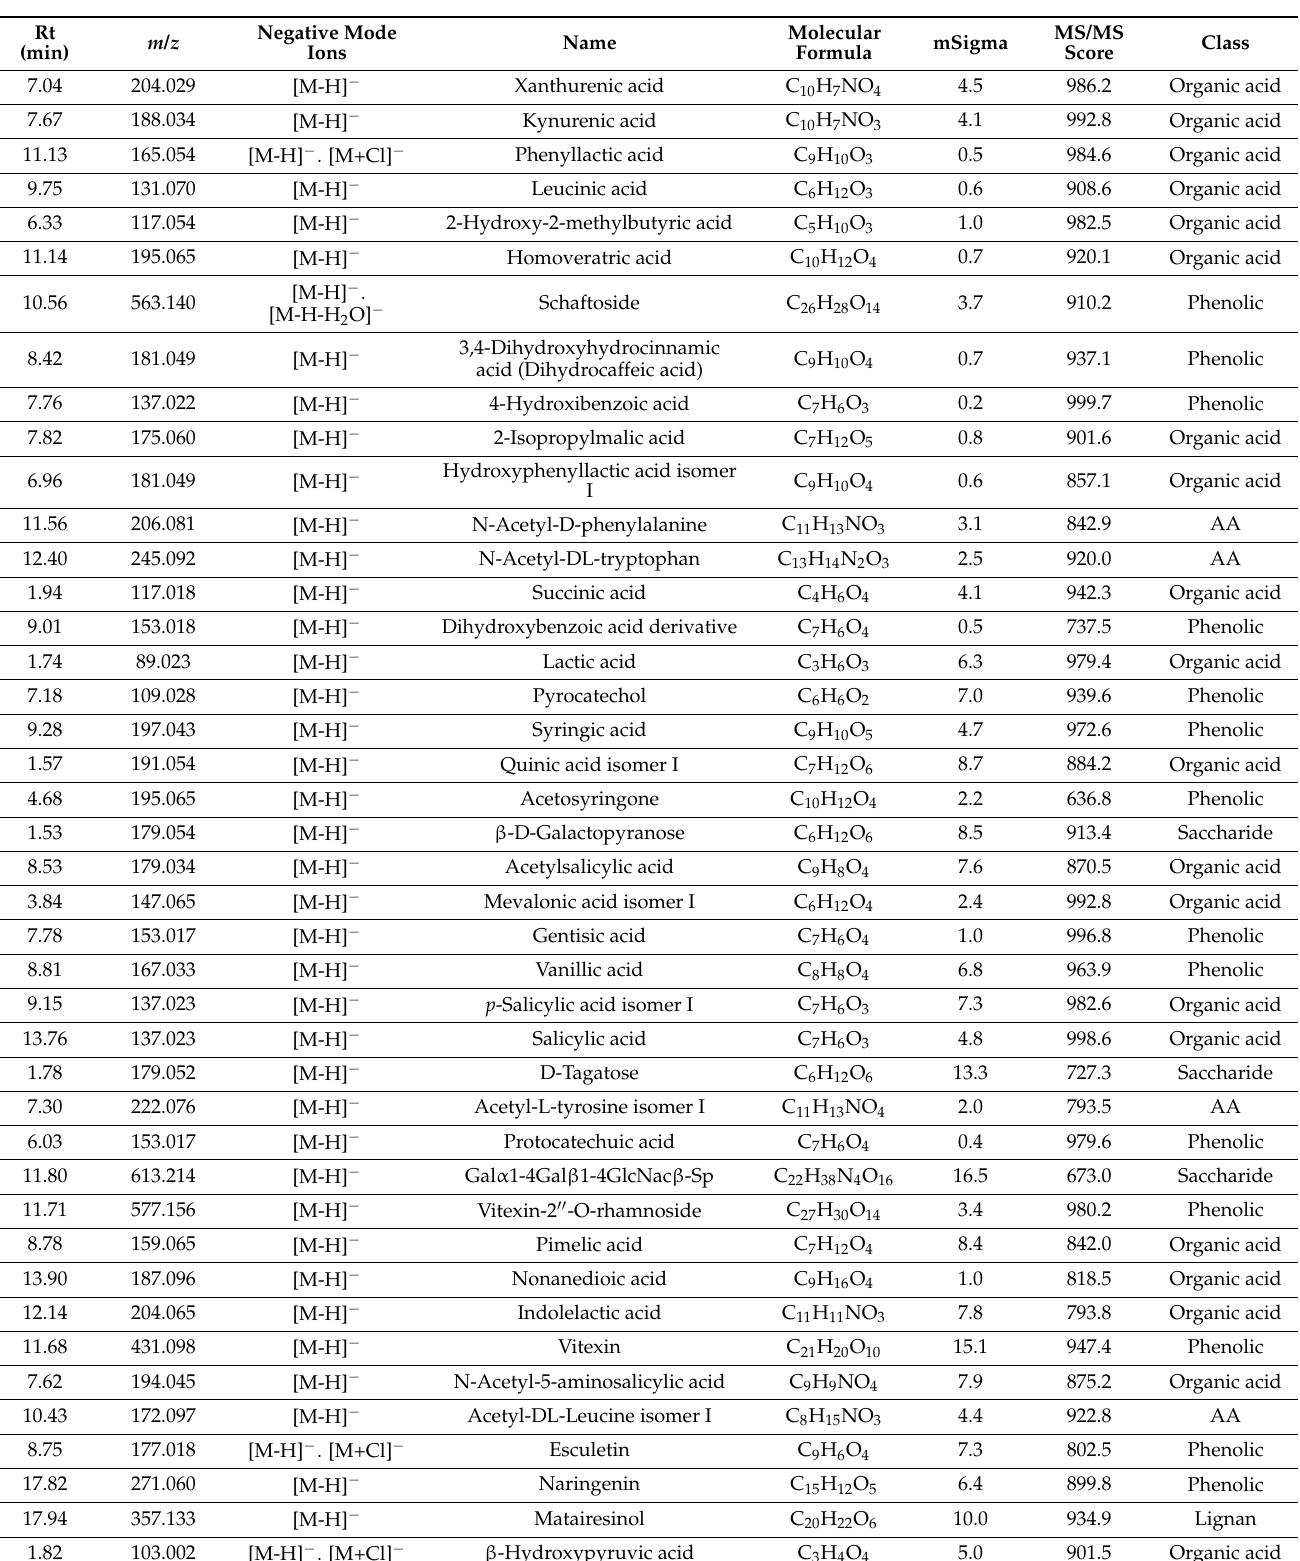
Table 6. Phenolic-rich extract characterization in negative ionization mode (From MetaboScape ® , ordered by decrease order of signal